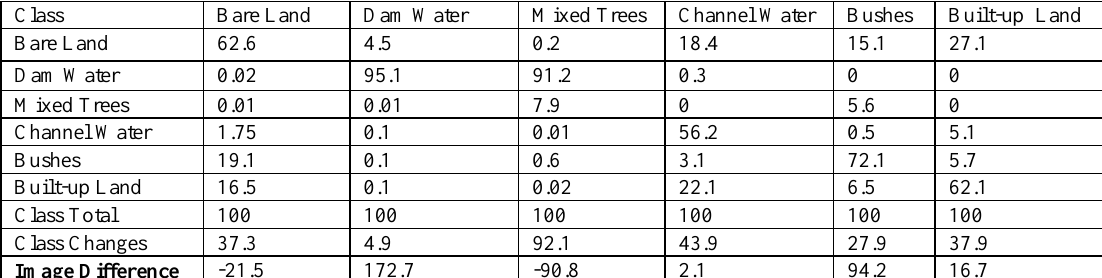
Table 5: Change Detection Percentage Operational Land Imager Data from Spring to Summer Season Class Bare Land Dam Water Mixed Trees